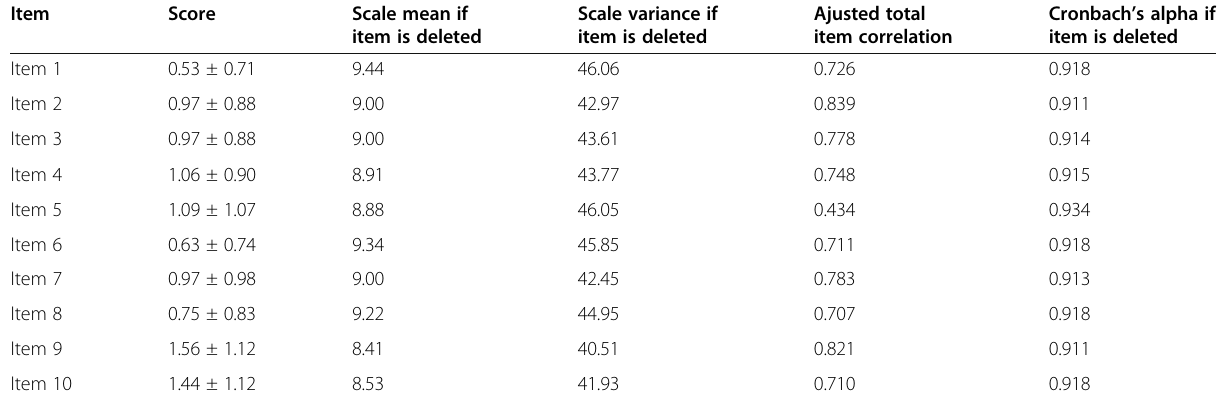
Table 4 Internal consistency of the Brazilian version of FIHOA Item Score Scale mean if